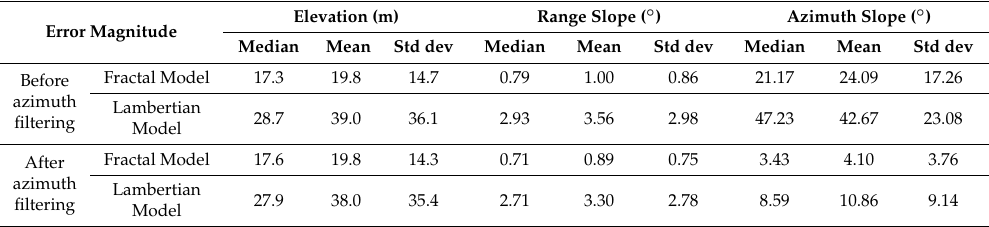
Table 5. Quality measures for the sinusoidal DEM: multilook case; known starting points in range